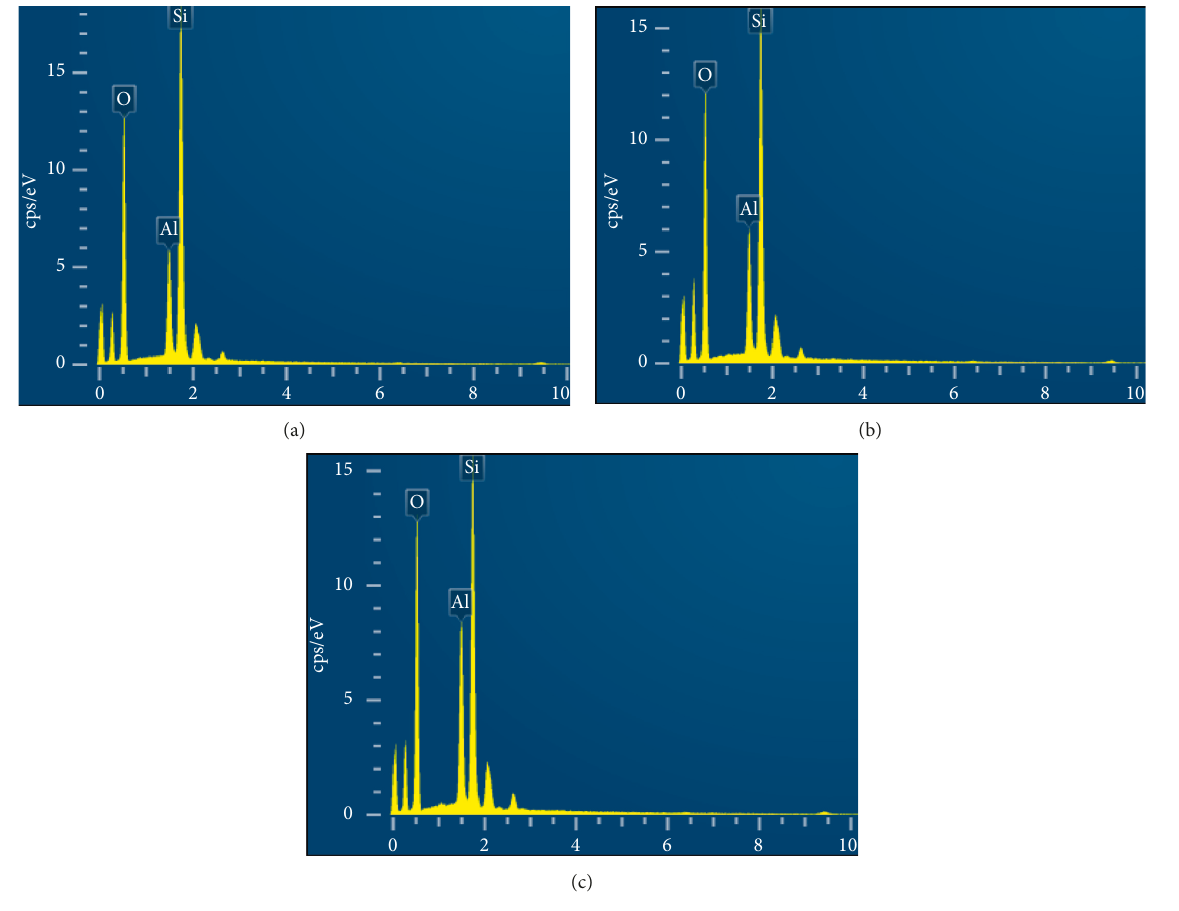
Figure 4: EDX of Al/SBA-15 (a), 2Al/SBA-15 (b), and 3Al/SBA (c). Table 3: EDX result Si, O, and Al content in xAl/SBA-15. Samples